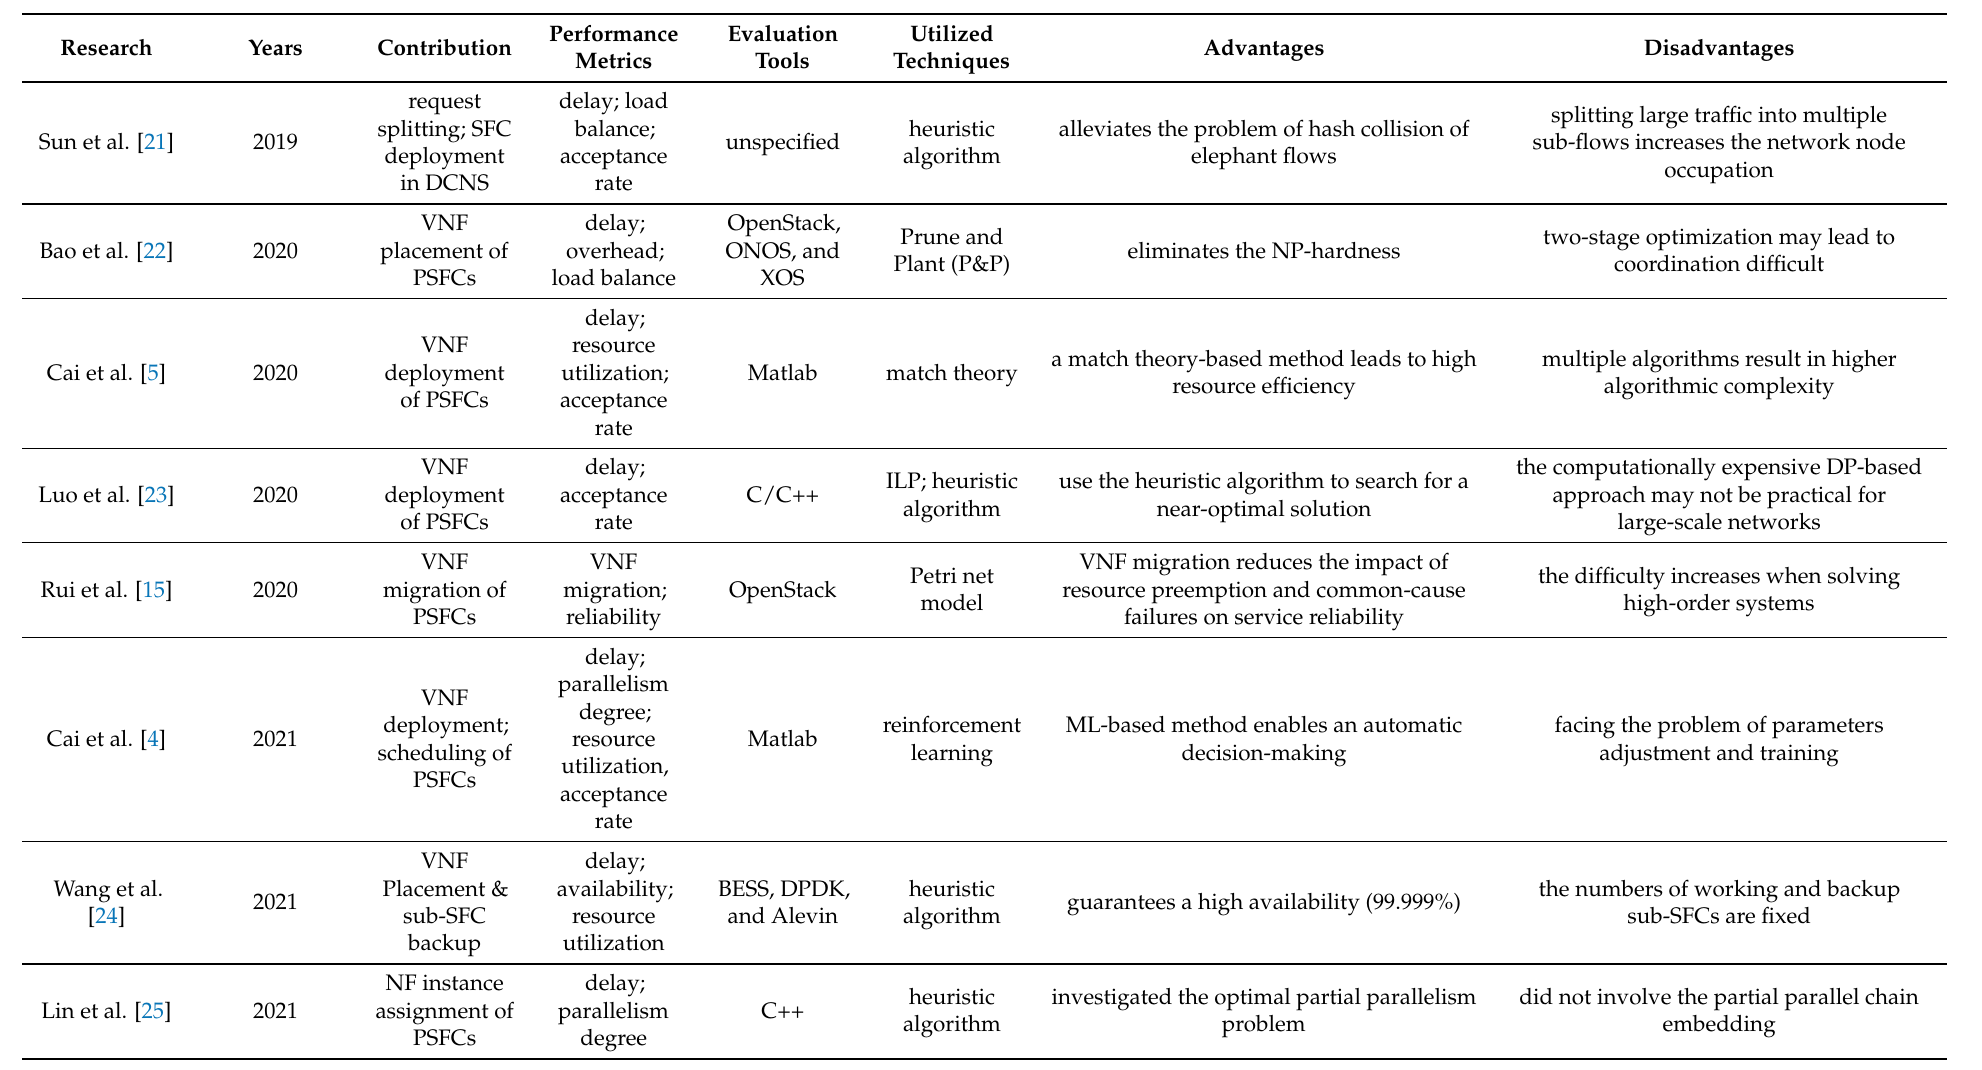
Table 2. A systematic review of PSFC deployment and scheduling